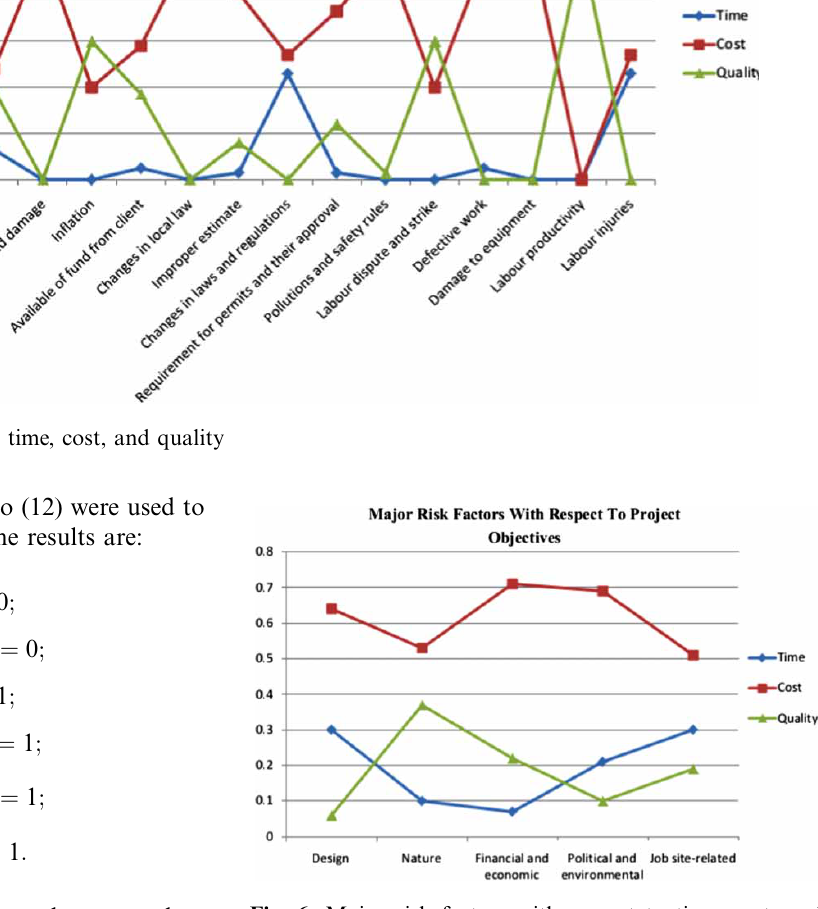
Fig. 6. Major risk factors with respect to time, cost, and